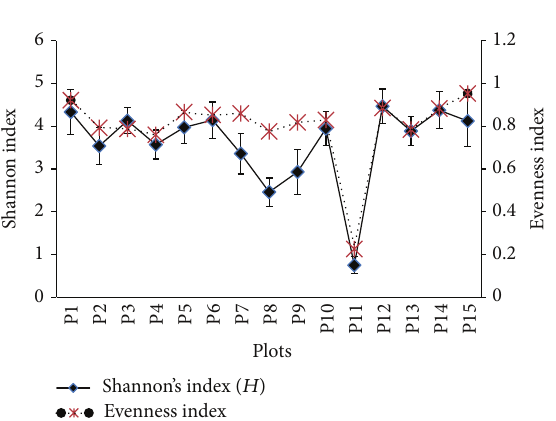
Figure 5: Similarity index between two types of forest. AF = agroforestry, FP = primary forest, and FS = secondary